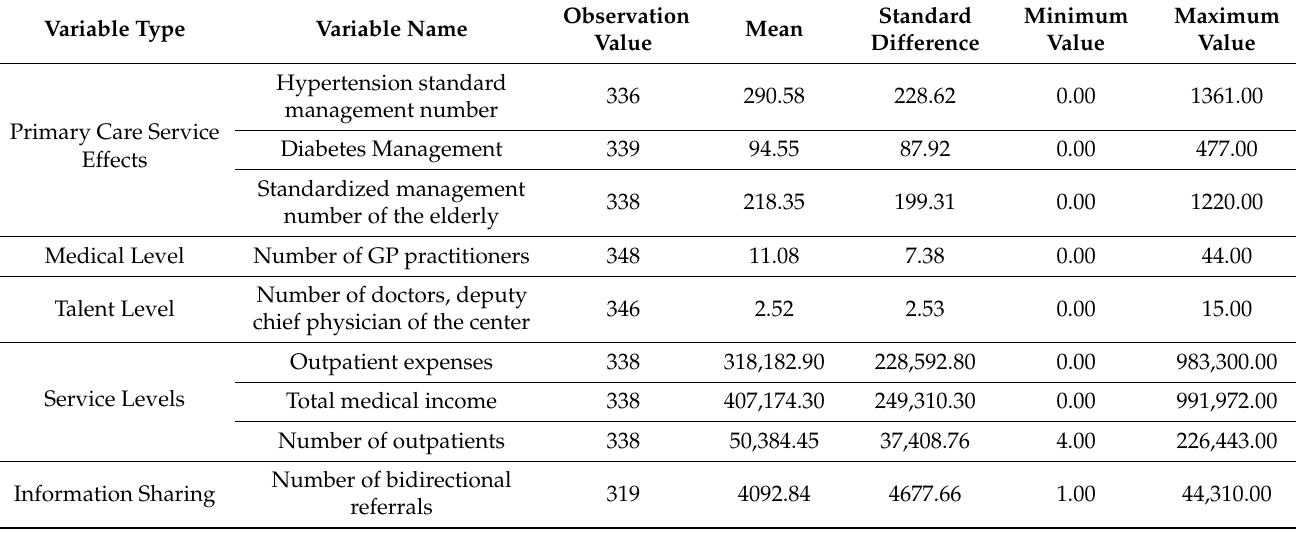
Table 5. Basic information of the primary care service